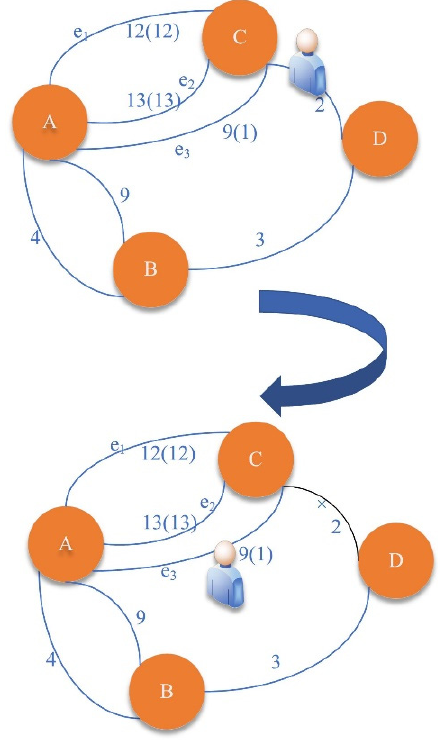
Figure 5. Dynamic congestion control.